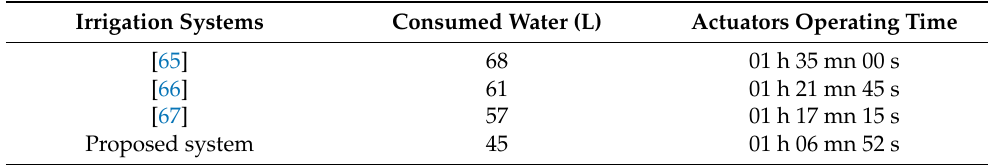
Table 7. Proposed system evaluation in aspects of actuator time and water consumption. Irrigation Systems